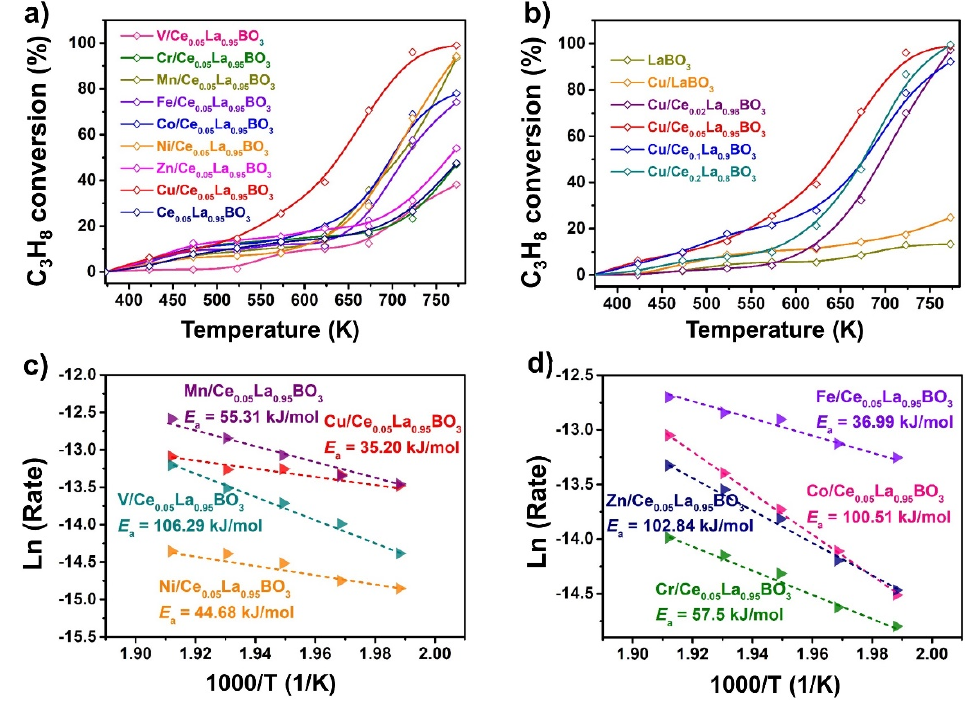
Figure 8. ( a , b ) Catalysis performance of LaBO 3 , Ce 0.05 La 0.95 BO 3 , and TMs/Ce 0.05 La 0.95 BO 3 ; ( c , d ) the Figure 8. ( a ) and ( b ) Catalysis performance of LaBO 3 , Ce 0.05 La 0.95 BO 3 , and TMs/ Ce 0.05 La 0.95 BO 3 ; ( c ) and ( d ) the apparent activation energy ( E a ) of TMs/ Ce 0.05 La 0.95 BO 3 , which was obtained with lower apparent activation energy ( E a ) of TMs/Ce 0.05 La 0.95 BO 3 , which was obtained with lower propane propane conversion (<15%). Test conditions: 1000ppm C 3 H 8 , balanced with air, WHSV = 20,000 conversion (<15%). Test conditions: 1000 ppm C 3 H 8 , balanced with air, WHSV = 20,000 mL · g cat − 1 · h − 1 . mL · g cat − 1 · h − 1 . Table 3. T10, T50, and T90 obtained with LaBO 3 , Ce 0.05 La 0.95 BO 3 , and TMs/Ce 0.05 La 0.95 BO 3 in propane combustion. Catalysts